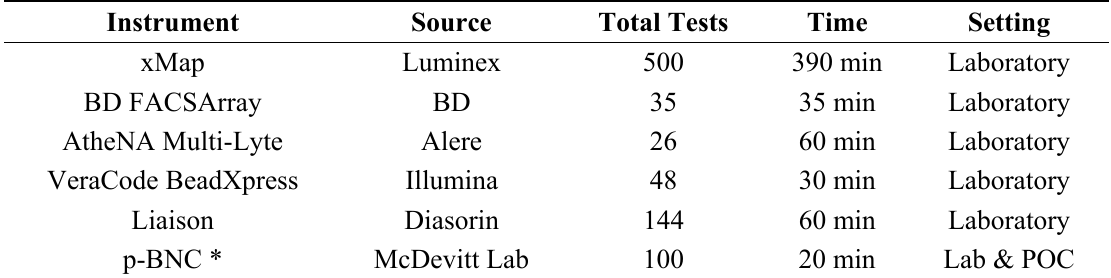
Table 3. List of bead-based instruments, number of different bead sensors for multiplexing, and total time to complete a